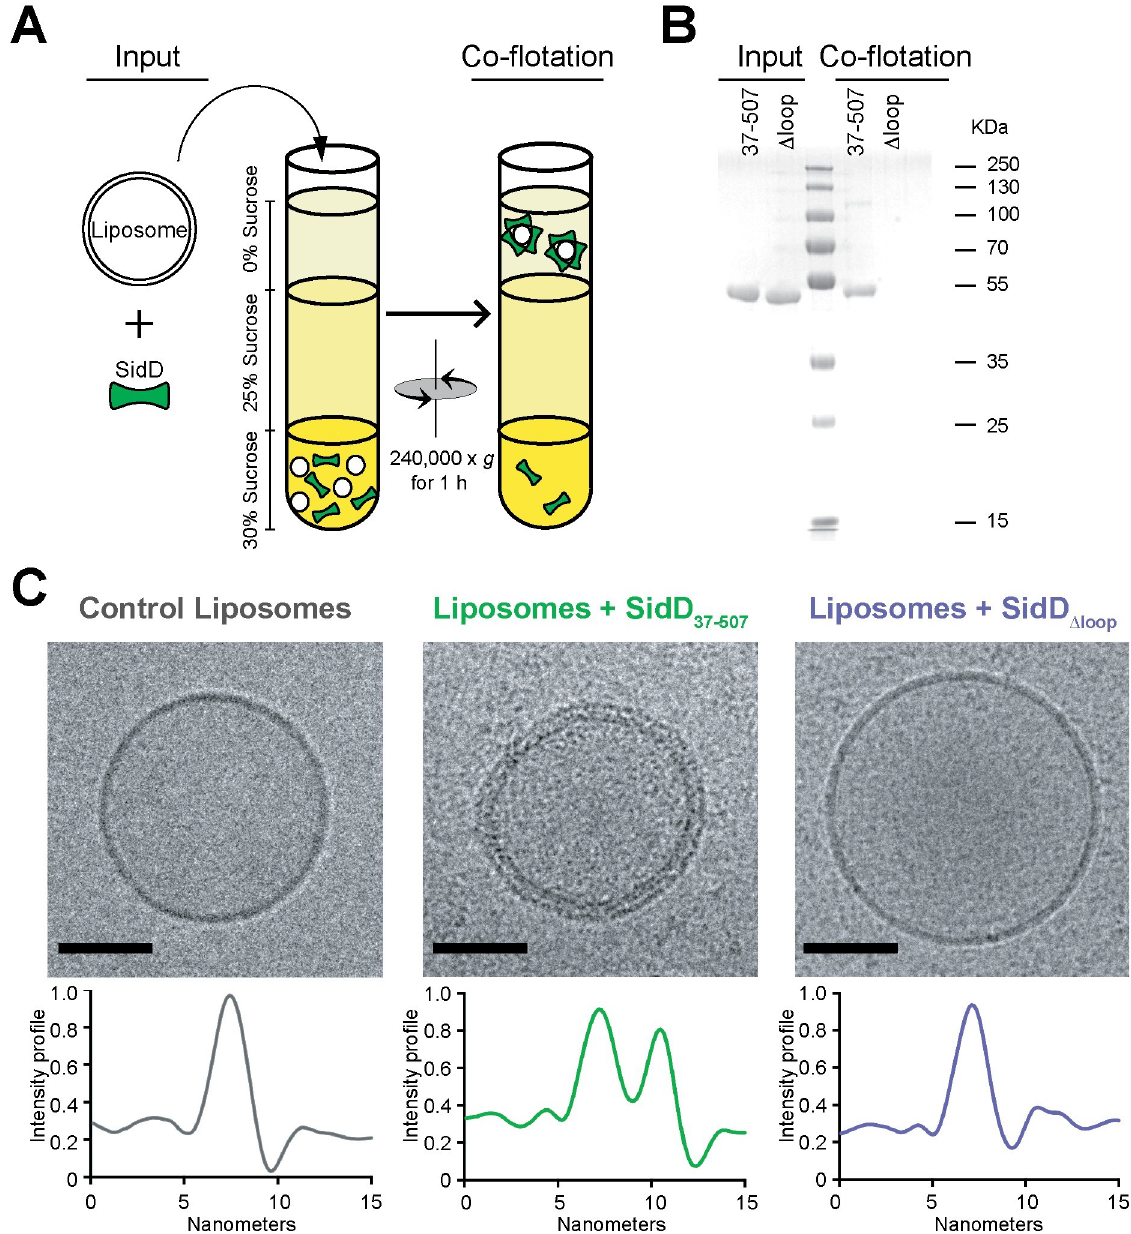
Fig 4. The hydrophobic loop is crucial for liposome binding of SidD during liposome flotation. (A) Illustration of the liposome flotation assay (left). (B) Coomassie blue-stained SDS-PAGE gel showing the binding of recombinant SidD 37-507 , but not SidD Δ loop , to free liposomes. (C) Representative cryo-EM images of a control liposome ( left ), a liposome incubated with SidD 37-507 ( middle ), and a liposome incubated with SidD Δ loop ( right ). Scale bar, 50 nm. The plot below each image represents the corresponding cross-sectional electron density profile along the perimeter of the liposome.